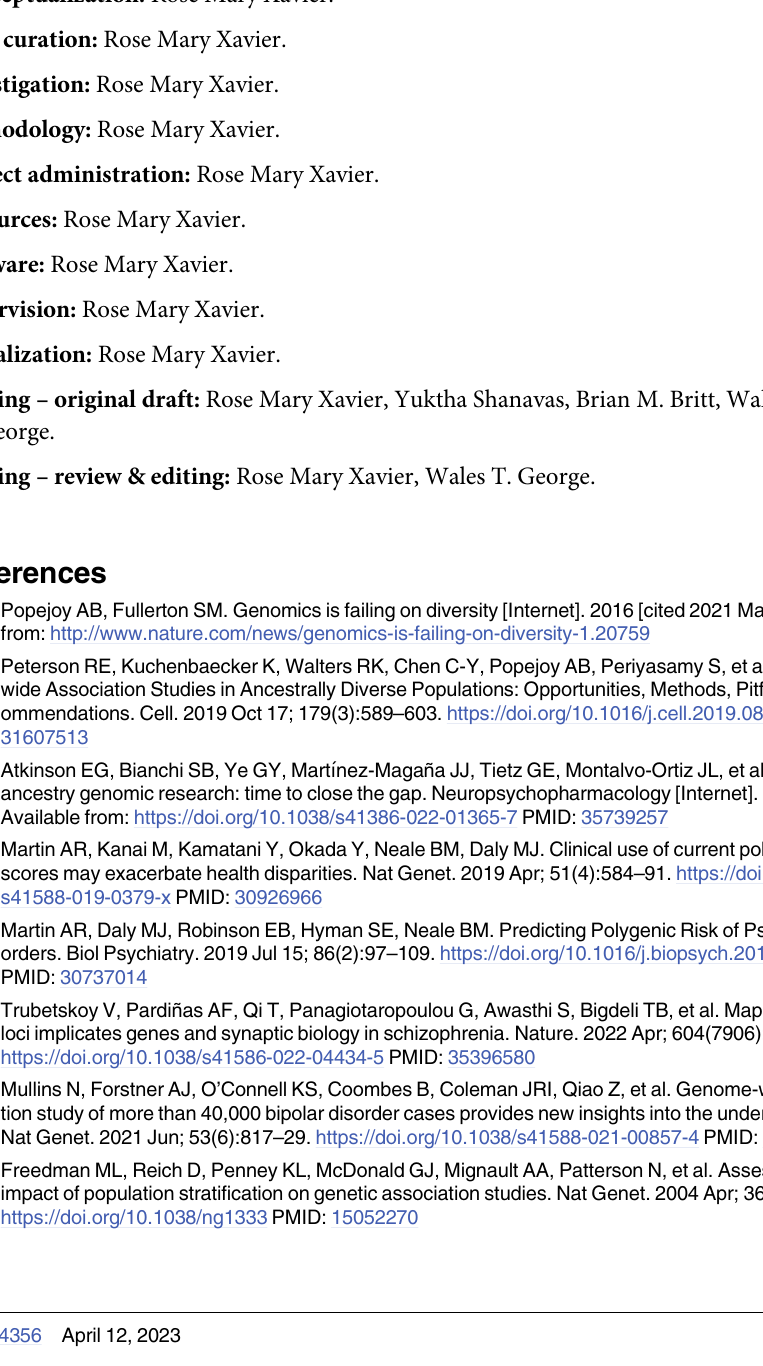
S1 Fig. Correlogram of relevant variables from baseline. Measures for variables are included in parenthesis. CDRS–Calgary Depression Rating Scale; CGIS–Clinical Global Impression of Symptom Severity; ITAQ–Illness and Treatment Attitude Questionnaire; MacCAT-CR–Mac- Arthur Competence Assessment Tool- Clinical Research; PANSS–Positive and Negative Syn- drome Scale; SF-12–12-item Short Form Survey; QLS–Heinrich-Carpenter Quality of Life